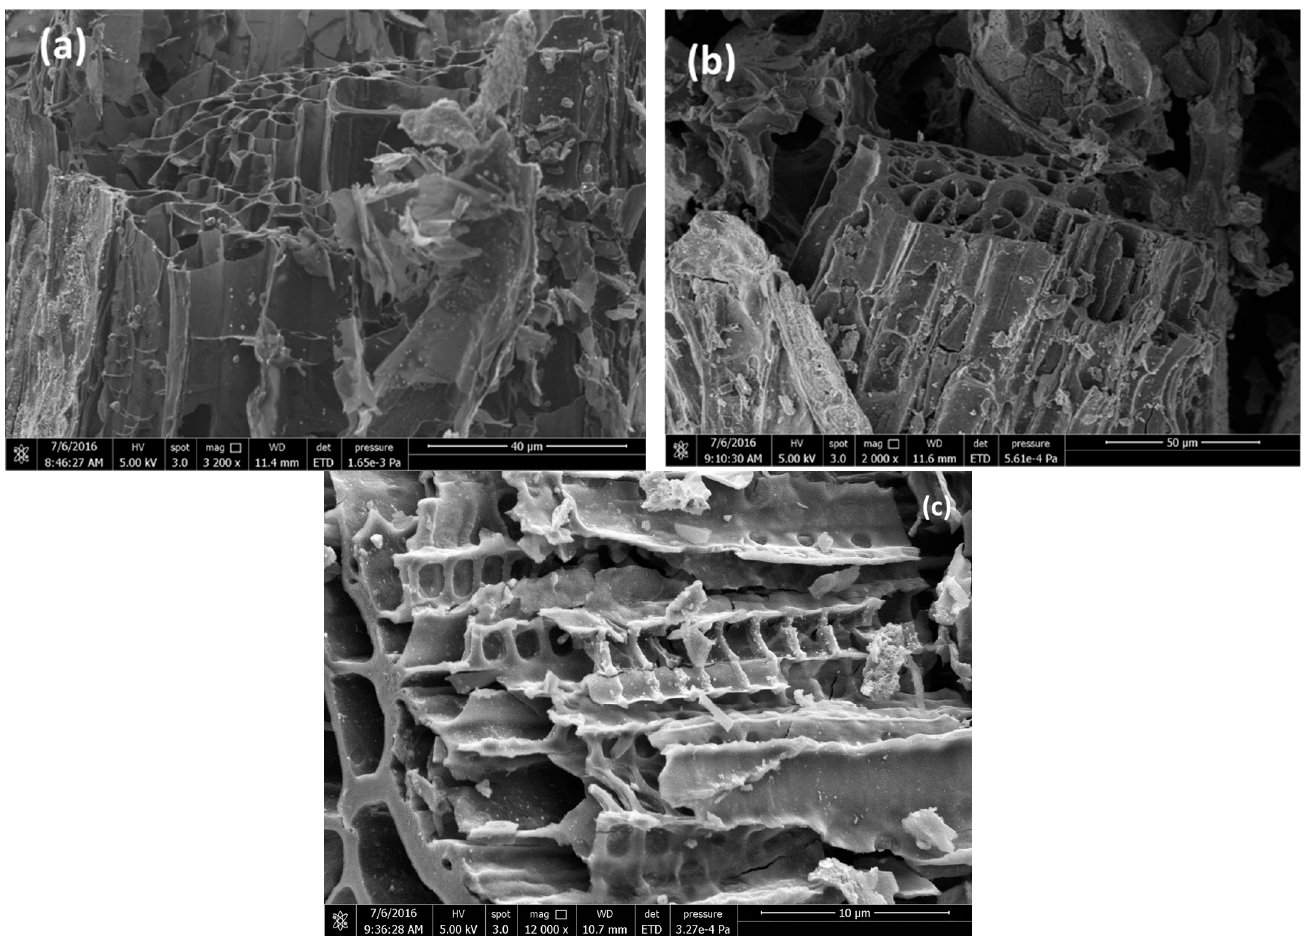
Figure 3. SEM images of the biochars studied; ( a ) Raw BC, ( b ) Base-treated BC, ( c ) Activated BC. Table 2. % atomic concentration of the different elements of biochars